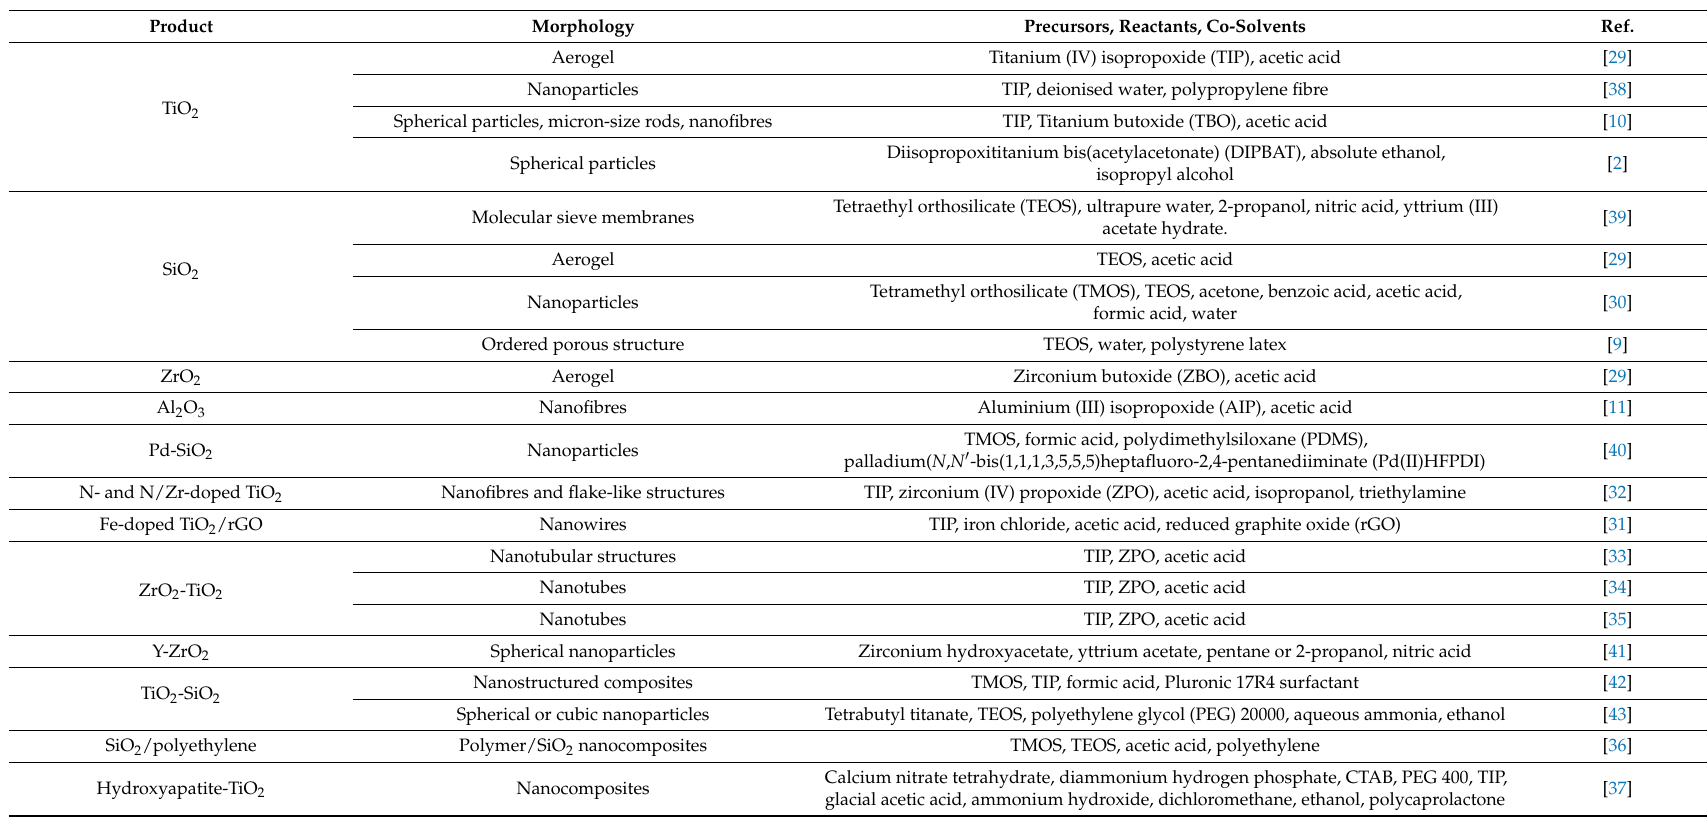
Table 1. Summary of methods for the direct sol-gel synthesis of nanostructured metal oxides (and silica) in scCO 2